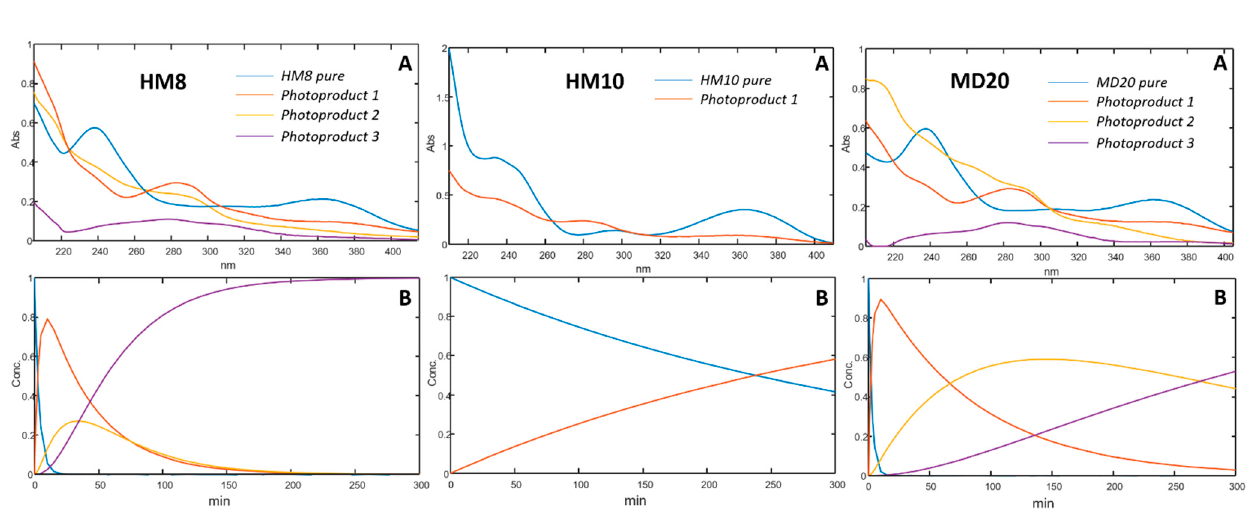
Figure 4. Spectra ( A ) and concentration profiles ( B ) for HM8, HM10 and MD20, and their photoproducts.